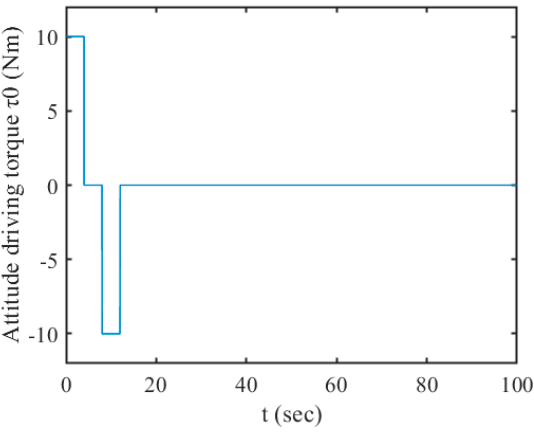
Figure 5. The a tt itude-driving torque pulse τ